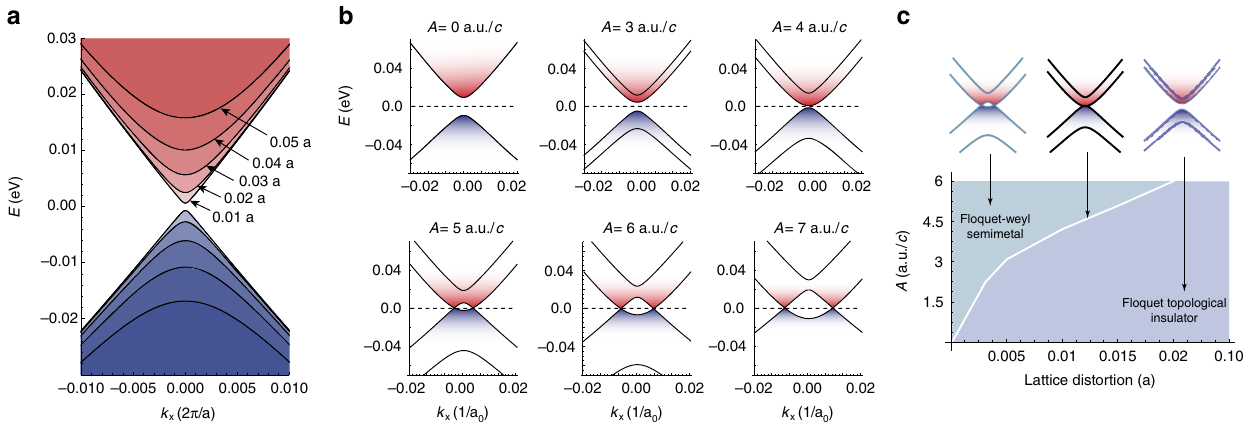
Figure 4 | Floquet topological phase transition and enhanced topological protection. ( a ) In strained samples, the breaking of crystal symmetries opens a gap at the 3D Dirac point, leading to a topological insulator phase. In Na 3 Bi, strain along x breaks the C 3 symmetry. Shown is a series of band structures for different lattice distortions measured as a fraction of the lattice parameter. ( b ) The strain-induced band gaps can be closed by the application of circularly polarized light. For 1% lattice distortion, increasing the amplitude of a y – z circularly polarized driving field with : O ¼ 1.5eV first reduces the gap, then closes it at a critical amplitude A c and restores the Floquet–Weyl semimetal observed in the unstrained case (see Fig. 2c). The units of the amplitude of the vector potential can be translated to electric field strength in units of V/Å. ( c ) This light-induced Floquet topological phase transition from topological insulator